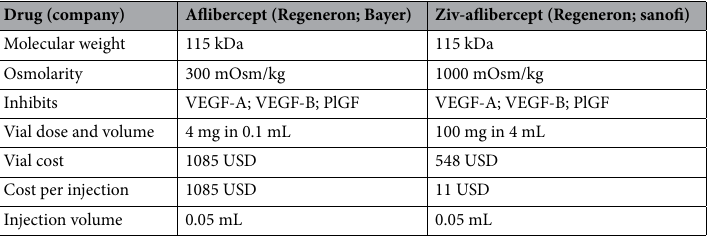
Table 1. Comparison of the two anti-VEGFs: aflibercept vs. Ziv-aflibercept 11 . Costs according to the Thailand National Drug Information 28